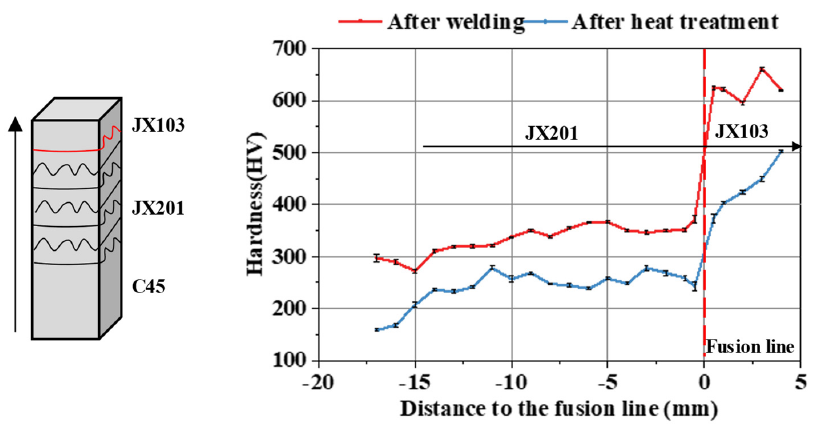
Figure 4. Microhardness distribution difference after welding and heat treatment (along the build- ing